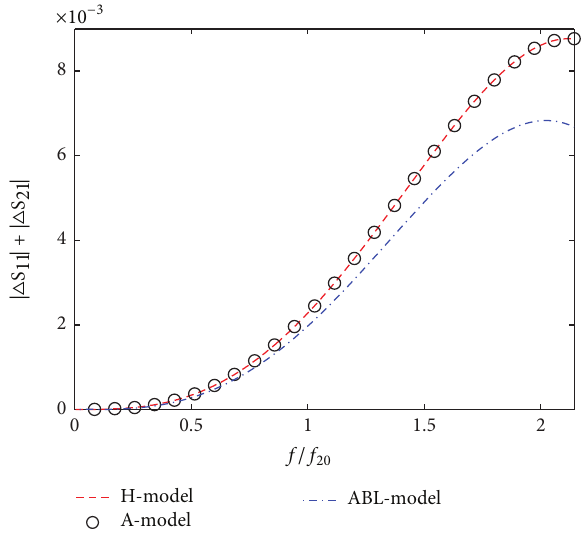
Figure 18: The 𝑆 -parameter differences at 𝜃 0 = 60 ∘ for three proposed models with angle-dependent parameters. Dashed-red curve: H-model; solid-black curve: A-model; dash-dotted-blue curve: